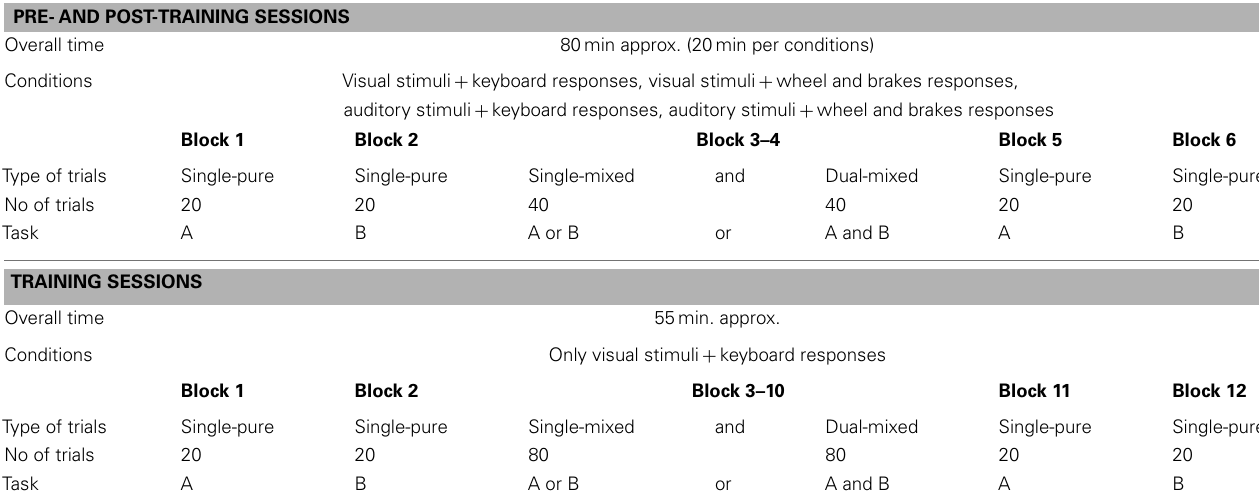
Table 2 | Content (blocks and trials) of the evaluation and training